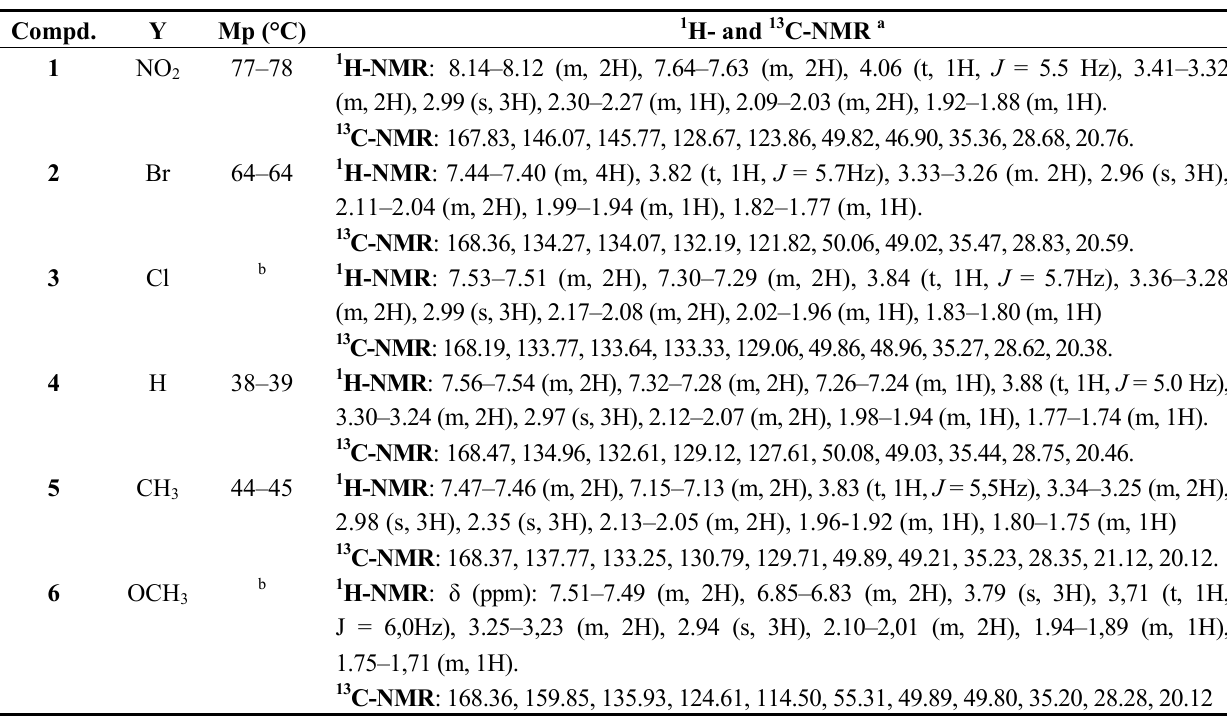
Table 6. Physical, 1 H- and 13 C-NMR data for 3-[(4 ′ -substituted-phenyl)sulfanyl]-1-methyl- 2-piperidones 1 – 6 .